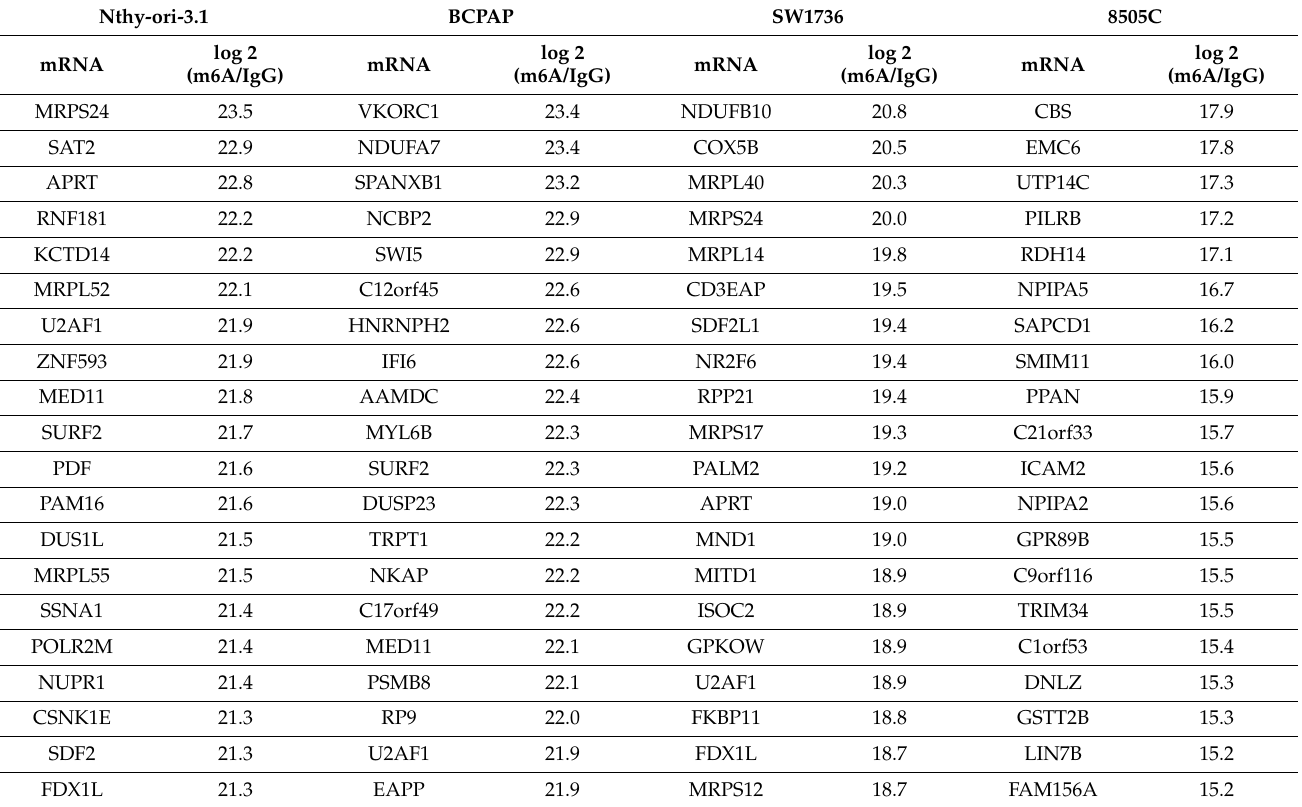
Table 2. Top 20 m6A-enriched mRNAs for Nthy-ori-3.1, BCPAP, SW1736, and 8505C cell